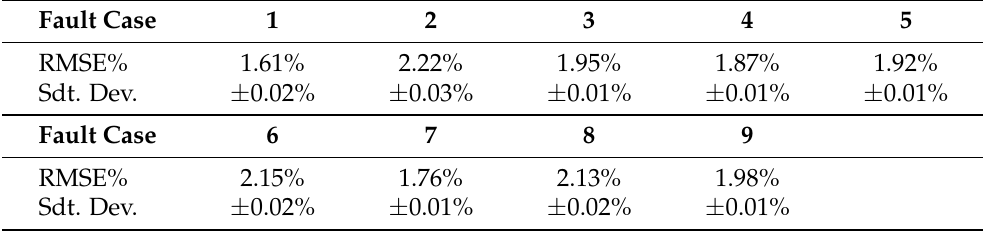
Table 4. FS fault estimator